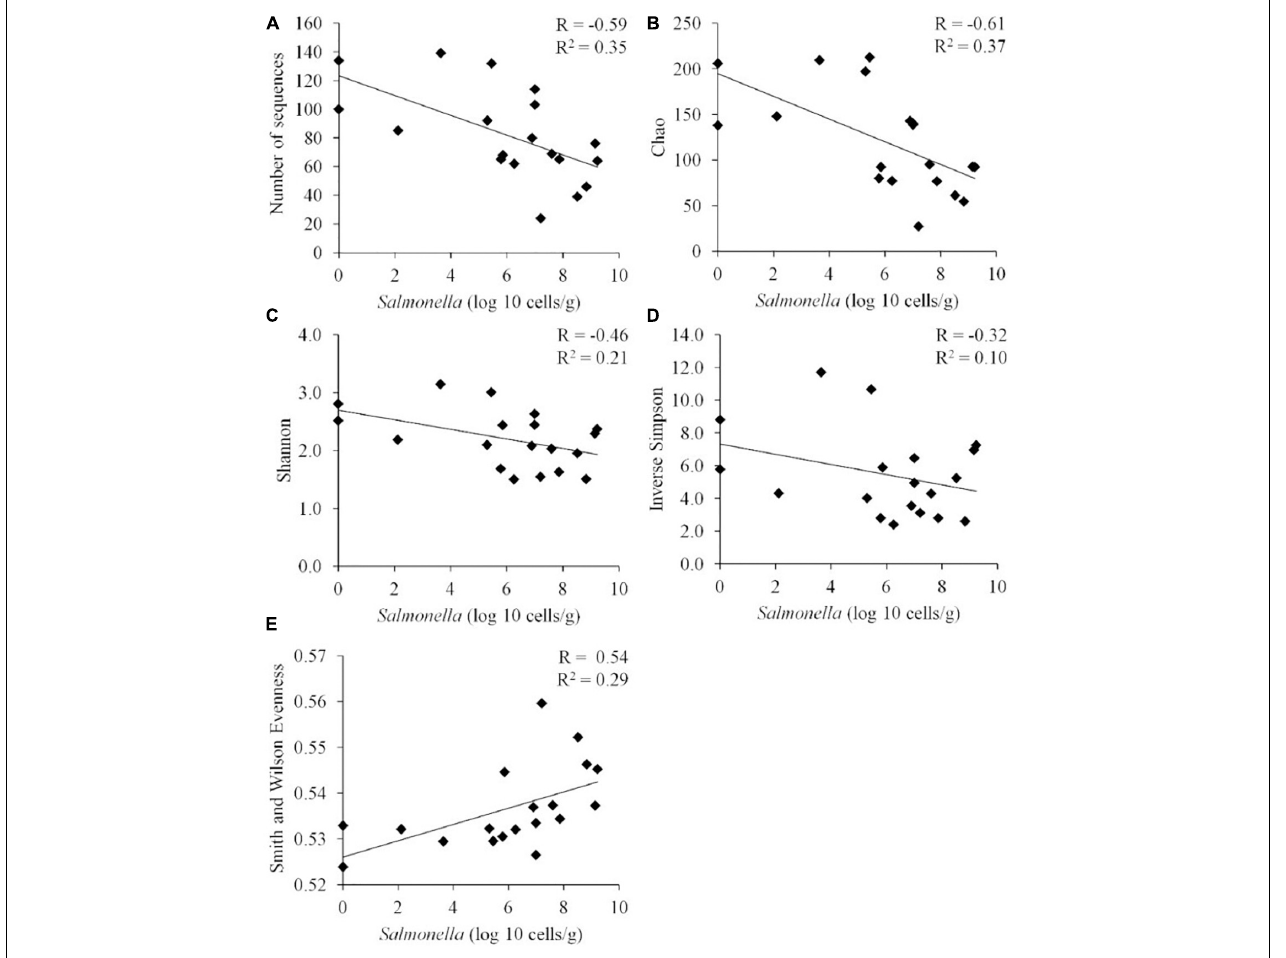
FIGURE 3 | Correlation between the Salmonella abundance and community diversity for all cecal communities ( n = 19). Community diversity was measured by number of unique OTUs (A) ( P < 0.01), Chao index (B) ( P < 0.01), Shannon index (C) ( P < 0.01), inverted Simpson index (D) ( p = 0.18), and Smith Wilson evenness index (E) ( P < 0.02). R , Pearson correlation coefficient; and R 2 , coefficient of determination.